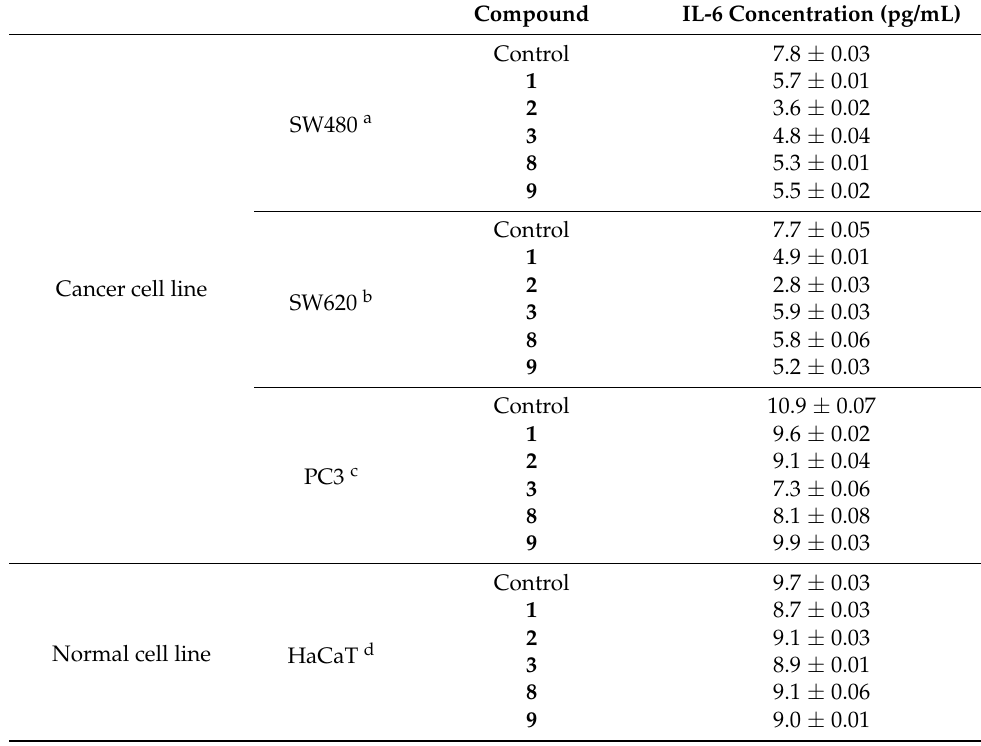
Table 3. Effects of compounds 1 – 3 , 8 , and 9 on IL-6 levels, measured by the ELISA test. Data are expressed as the mean ± SD from a Human primary colon cancer (SW480), b Human metastatic colon cancer (SW620), c Human metastatic prostate cancer (PC3), d Human immortal keratinocyte cell line from adult human skin